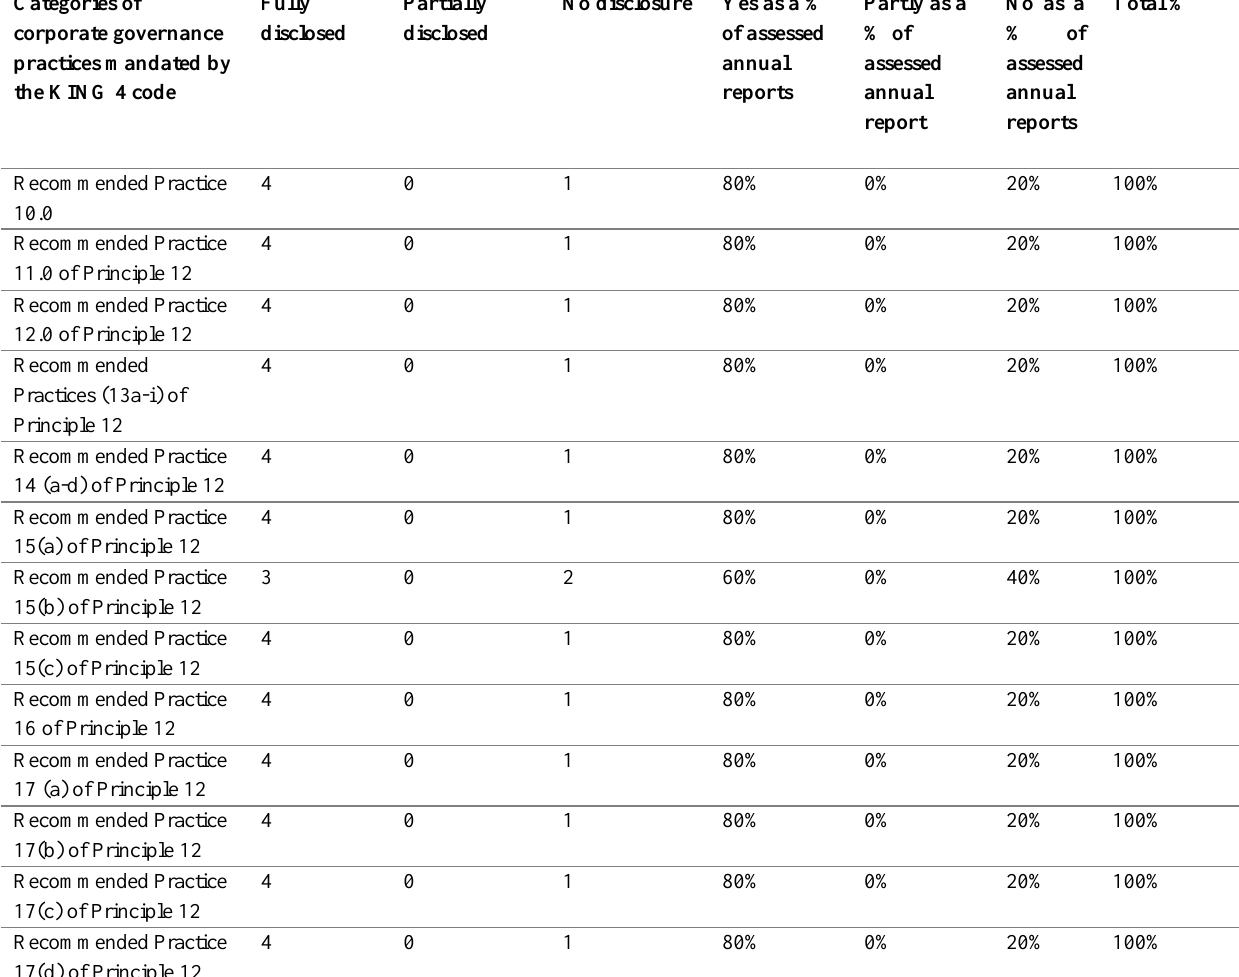
Table 4: Summary of